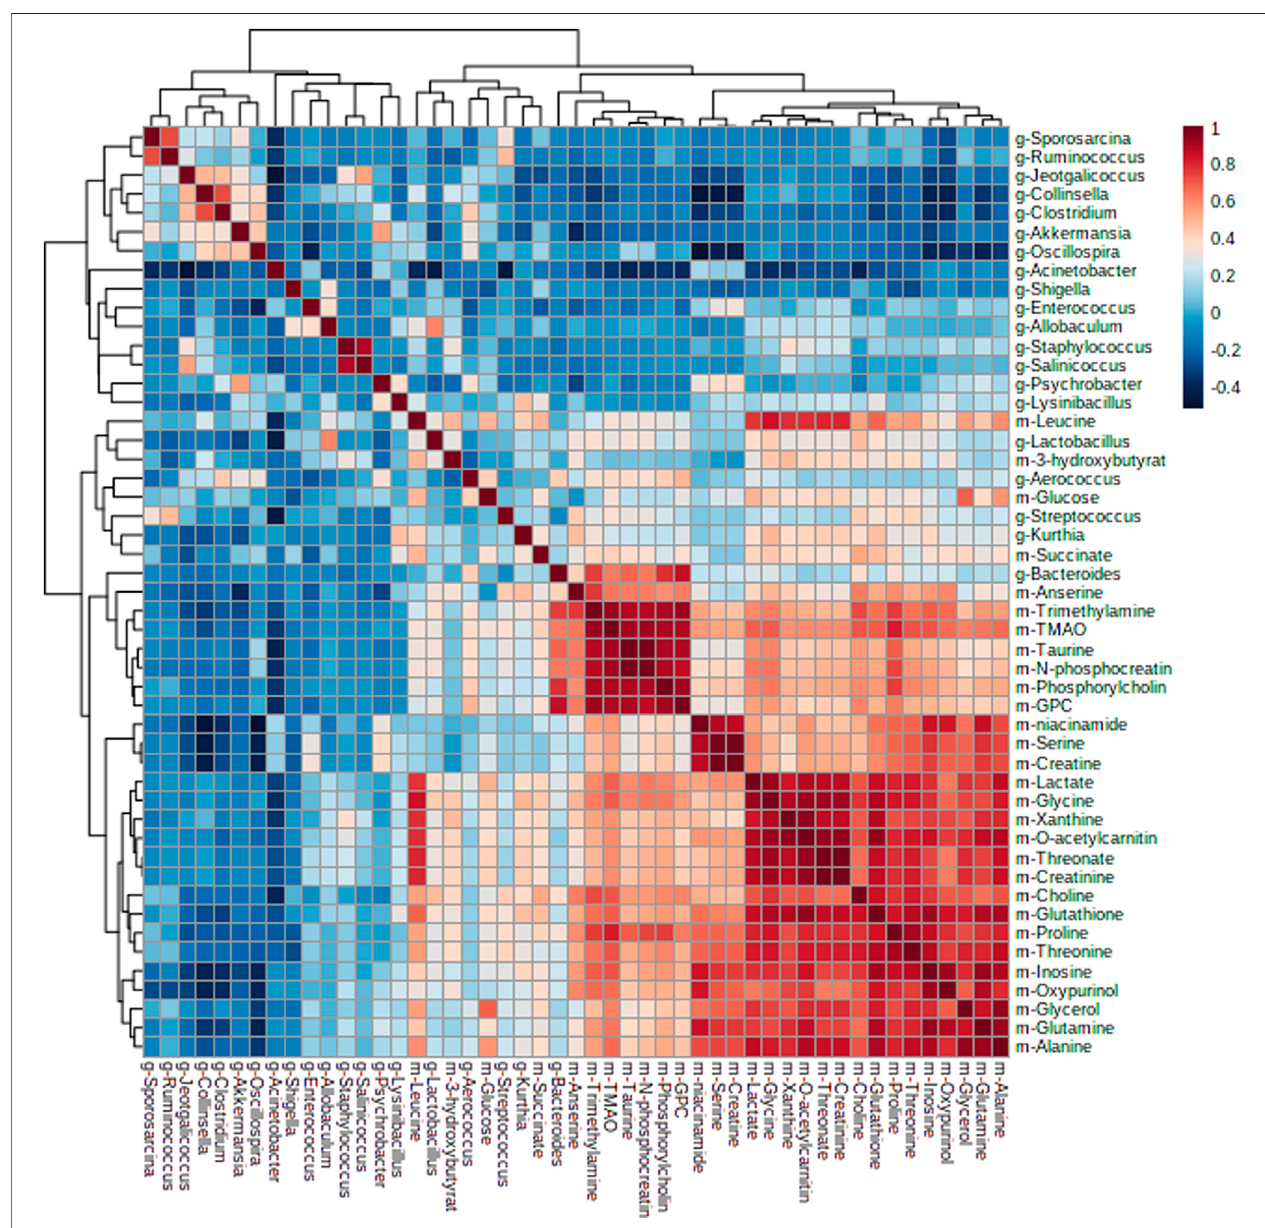
FIGURE 6 | Heatmap of correlation analysis results between intestinal fl ora and liver metabolites.